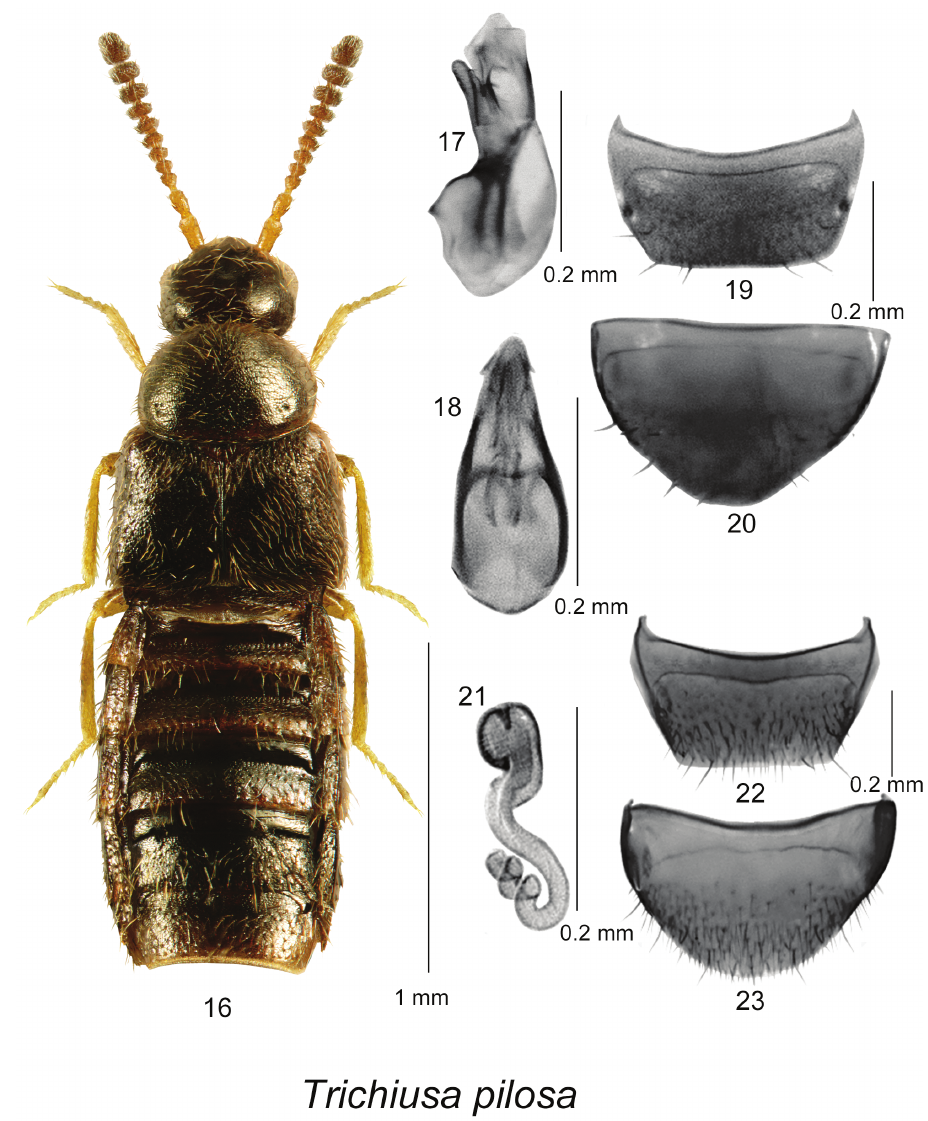
Figures 16–23. Trichiusa pilosa Casey: 16 habitus in dorsal view 17 median lobe of aedeagus in lateral view, and 18 in dorsal view 19 male tergite VIII 20 male sternite VIII 21 spermatheca in lateral view 22 female tergite VIII 23 female sternite VIII 17–23 based on type material from Rhode Island, USA.